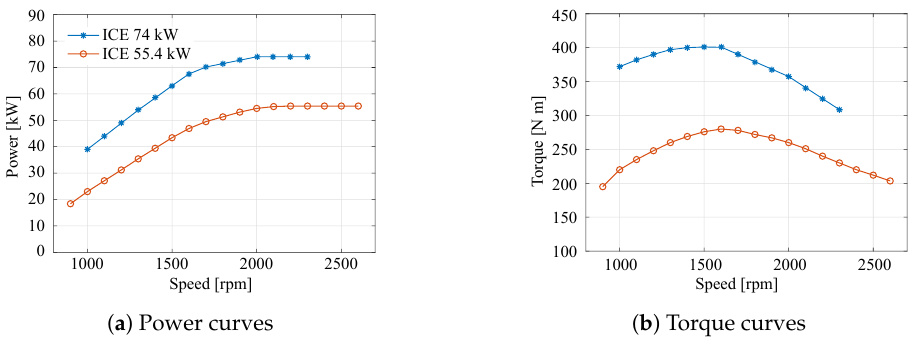
Figure 1. Powertrain performance comparison. The 74kW [19] Internal Combustion Engine (ICE) of the traditional powertrain is considered as a project target; the downsized 55.4kW [20] ICE is considered for the hybrid powertrain. These characteristics are obtained from the technical data sheets of two specific ICEs.